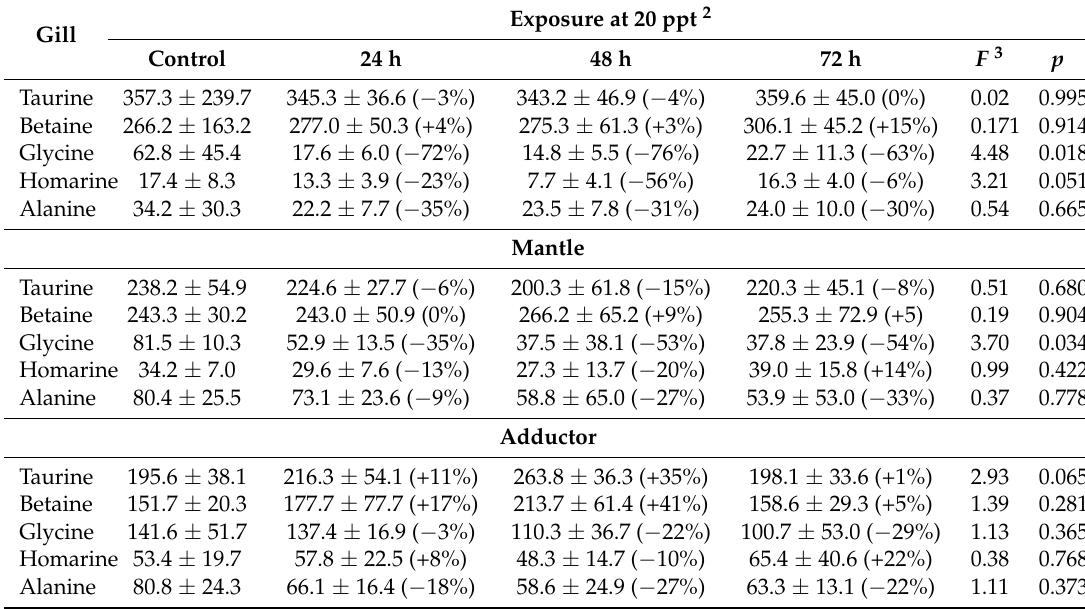
Table 2. Free amino acid concentrations 1 in juvenile mussels following low salinity